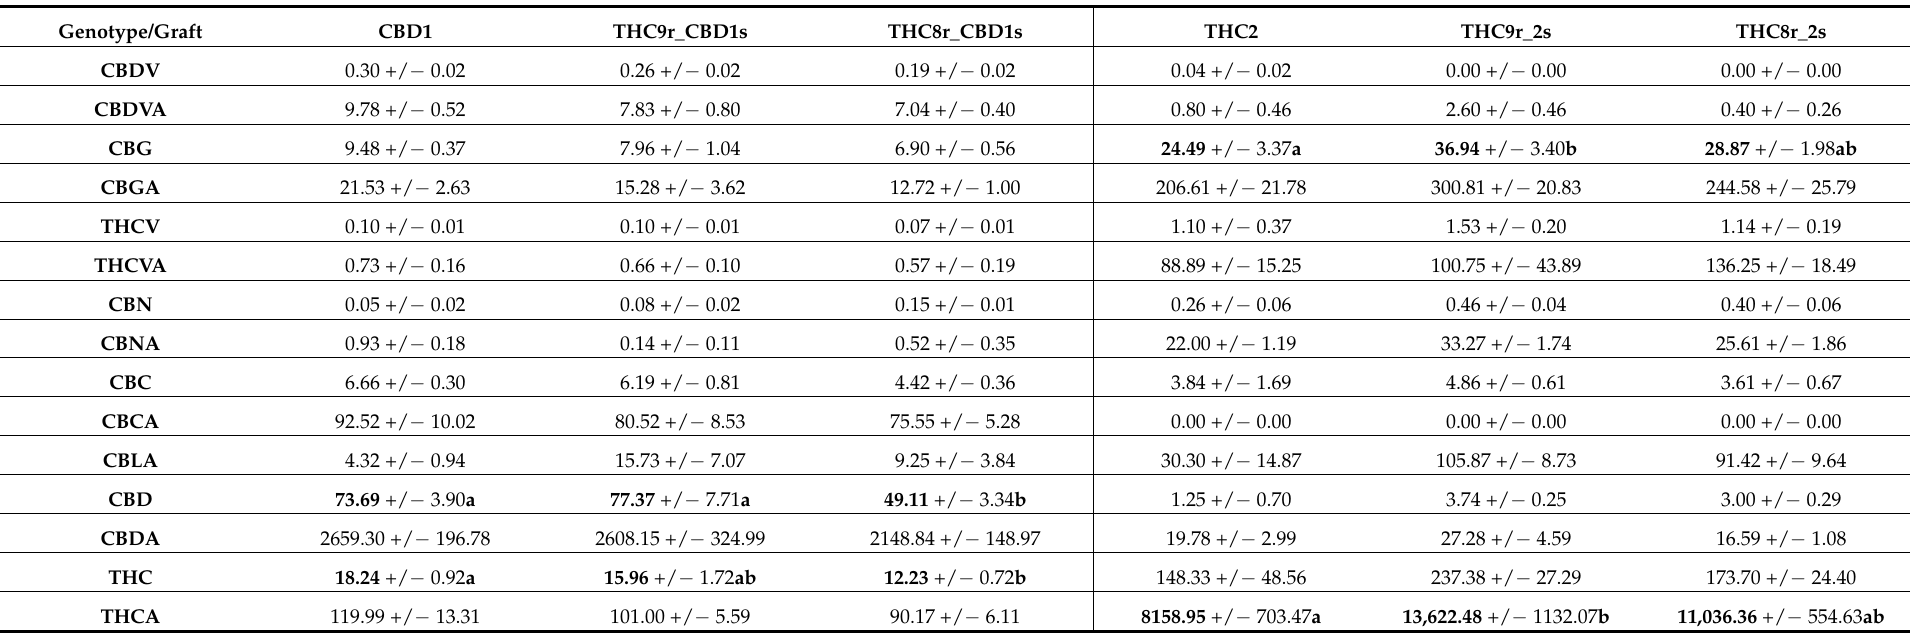
Table 6. Total yield of cannabinoids (mg Plant − 1 ) in control genotypes and grafted scions. N = 3–4 +/ − = SE. Values shown in bold and letters below them denote significant differences between genotypes/grafts (Tukey HSD, p ≤